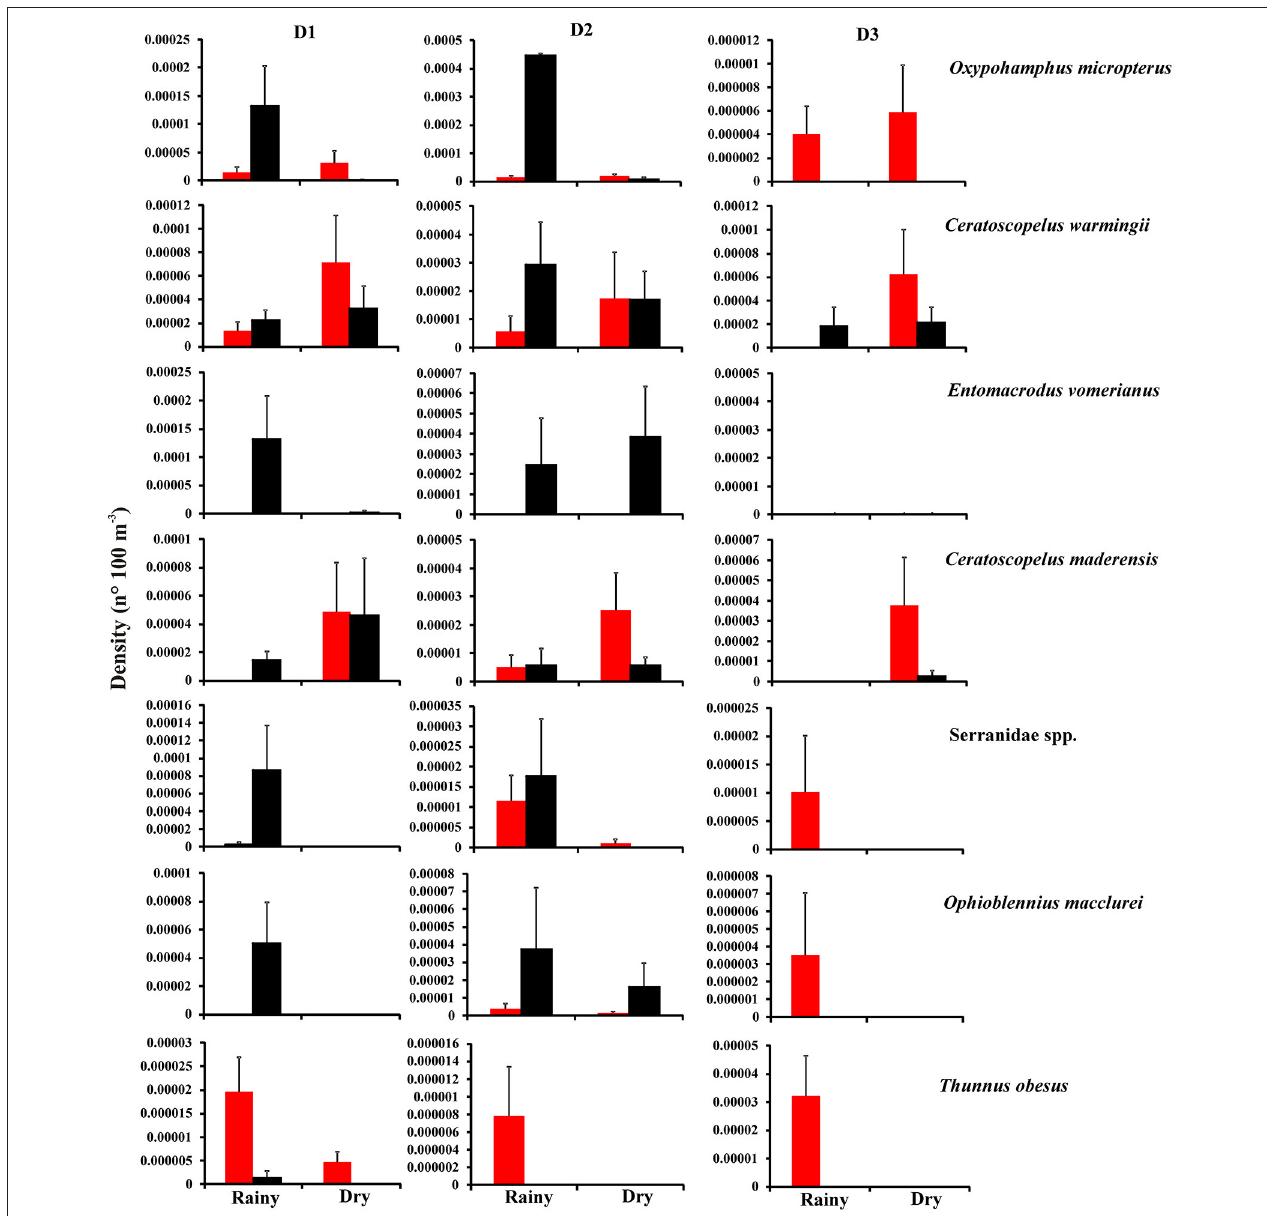
FIGURE 5 | Total mean ( + S.E.) density of the most abundant larval fish species in different periods [( ) day and ( (cid:4) ) night] at D1 ( < 100 m), D2 ( > 100–500 m), and D3 ( > 500–1500 m) for each season (rainy and